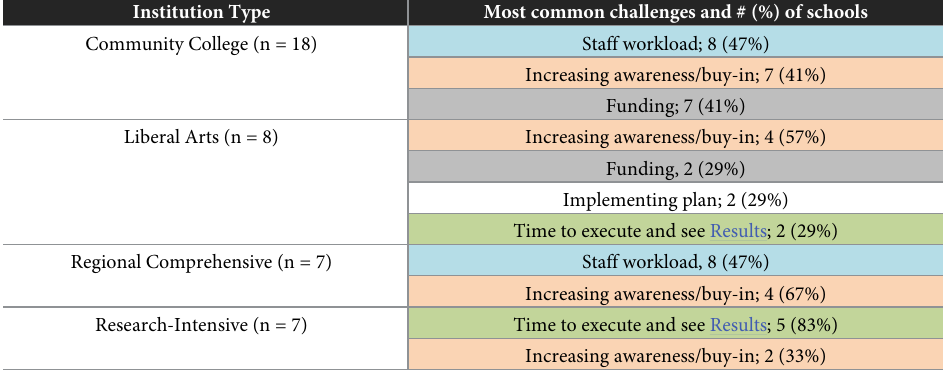
Table 2. Most common challenges reported by institutions on their progress-to-date posters presented at NW BIO reported by institution type (n = 36 of 40 posters reported challenges). Barriers are matched by color if they appeared in more than one institution